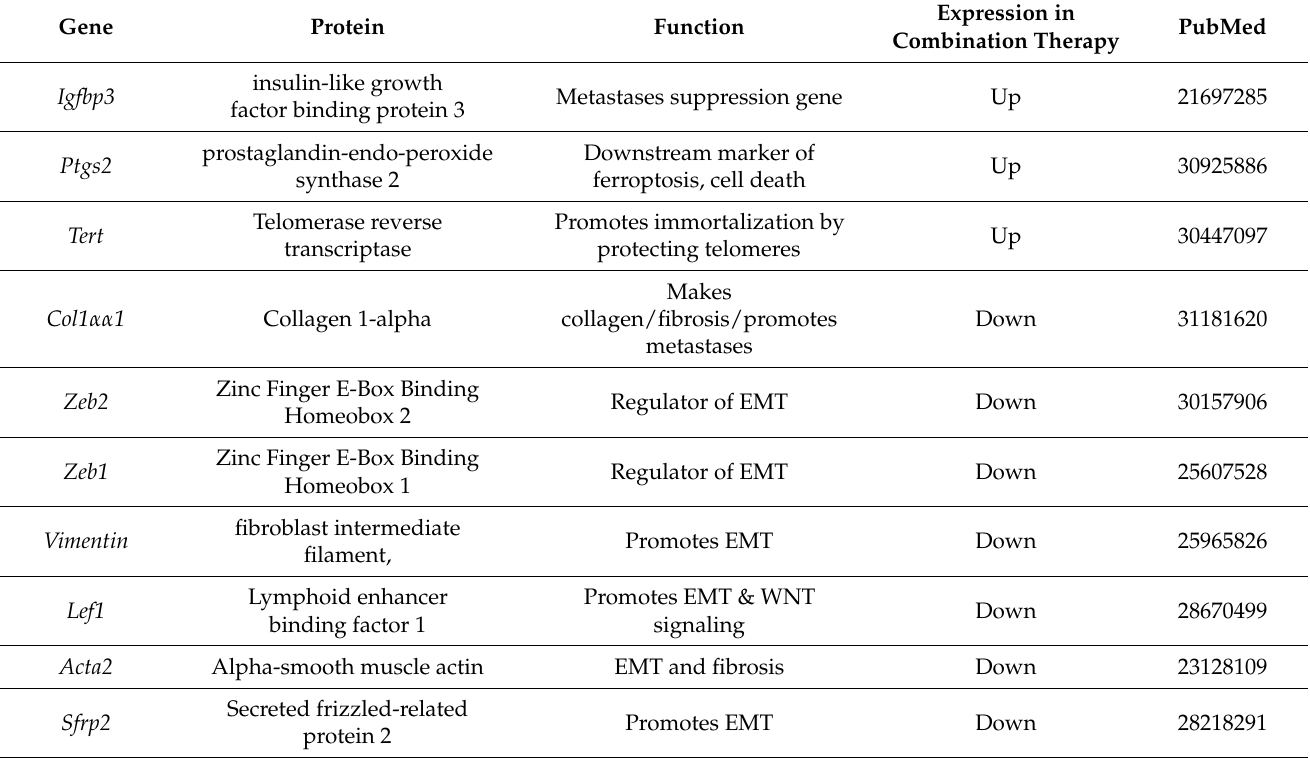
Table 1. Description of the top 10 DEGs from tumors of control versus Combo-treated mice and the PubMed reference